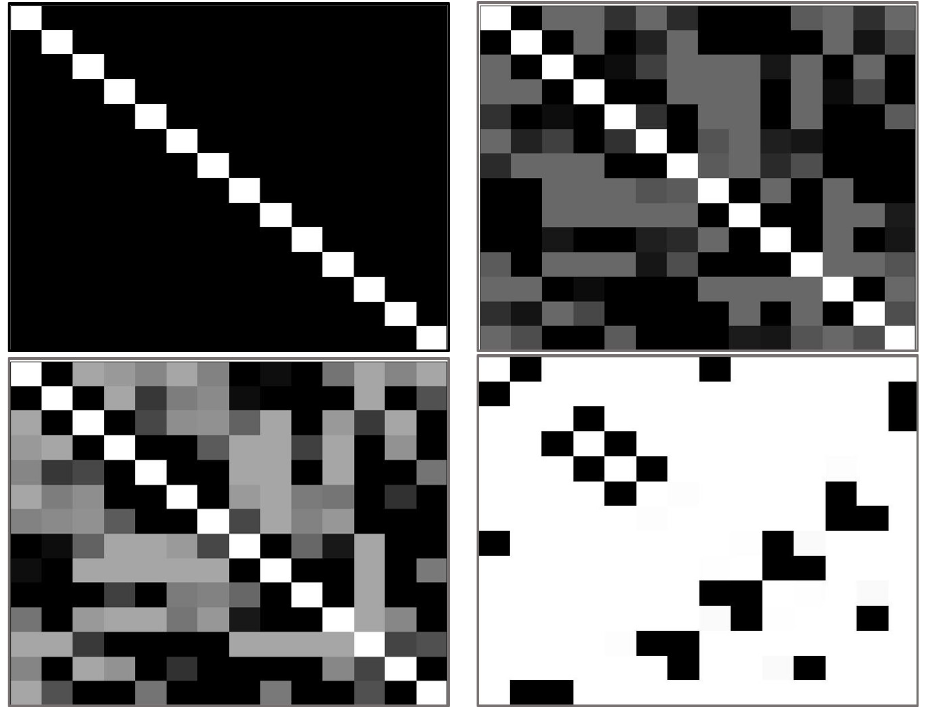
Figure 2. A visual representation of the pheromone matrix: ( left - right , top - bottom ) the pheromone values obtained with AS Rank applied to the TSPLIB instance burma14 with 14 cities, after 0, 5, 10 and 100 iterations,